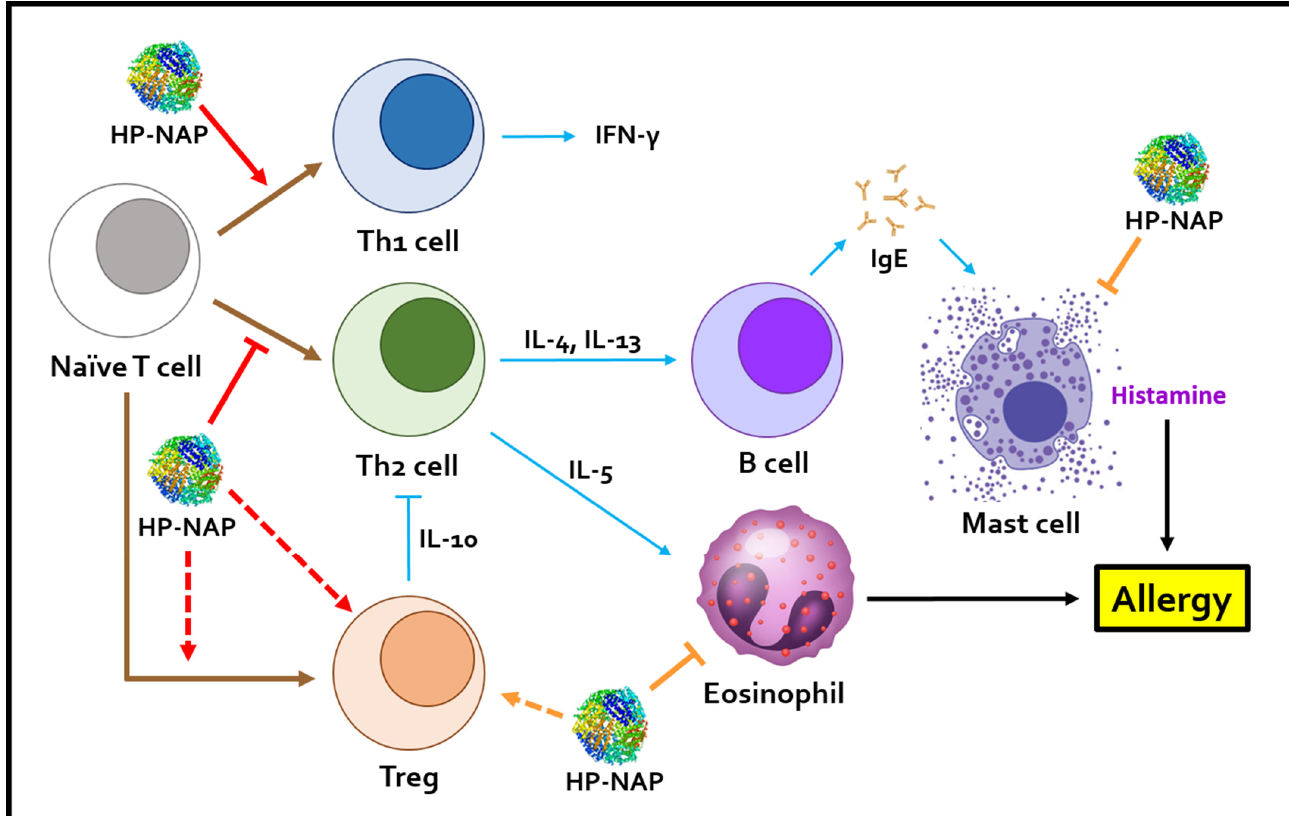
Figure 2. Schematic presentation of how HP-NAP reduces the allergy by shifting the immune re- sponse from a Th2 to a Th1 response. HP-NAP promotes the differentiation of naïve T cells into Th1 cells and suppresses the differentiation of naive T cells into Th2 cells, thus increasing the release of Th1 cytokines, such as IFN- γ , and reducing the release of Th2 cytokines, including IL-4, IL-5, and IL-13, respectively. The reduced Th2 cytokine production and reduced B cell-mediated immune re- sponse could lead to a reduction of histamine secretion by mast cells. The increased number of Tregs induced by HP-NAP could be due to the promotion of their differentiation or their infiltration into mucosa tissue. HP-NAP could promote the secretion of Treg cytokine, IL-10, leading to the suppres- sion of activity of Th2 cells. HP-NAP also reduced the infiltration of eosinophils into airway mucosa tissues in allergic asthma and mast cells to the skin tissue in atopic dermatitis. “ ↓ ” indicates induc- tion; “ ⊥ ” indicates inhibition; brown arrows indicate differentiation; red arrows indicate the stim- ulation of cell differentiation by HP-NAP; blue arrows indicate stimulation of cellular activity; or- ange arrows indicate the stimulation of cell infiltration by HP-NAP; dot arrows indicate the possible stimulation which has not been directly proved in research papers. HP-NAP, H. pylori neutrophil- activating protein; Th1, T-helper type 1; Th2, T-helper type 2; Treg, regulatory T cell; IL-4, interleu- kin-4; IL-5, interleukin-5; IL-10, interleukin-10; IL-13, interleukin-13; IFN- γ , interferon- γ ; IgE, im- munoglobulin E.